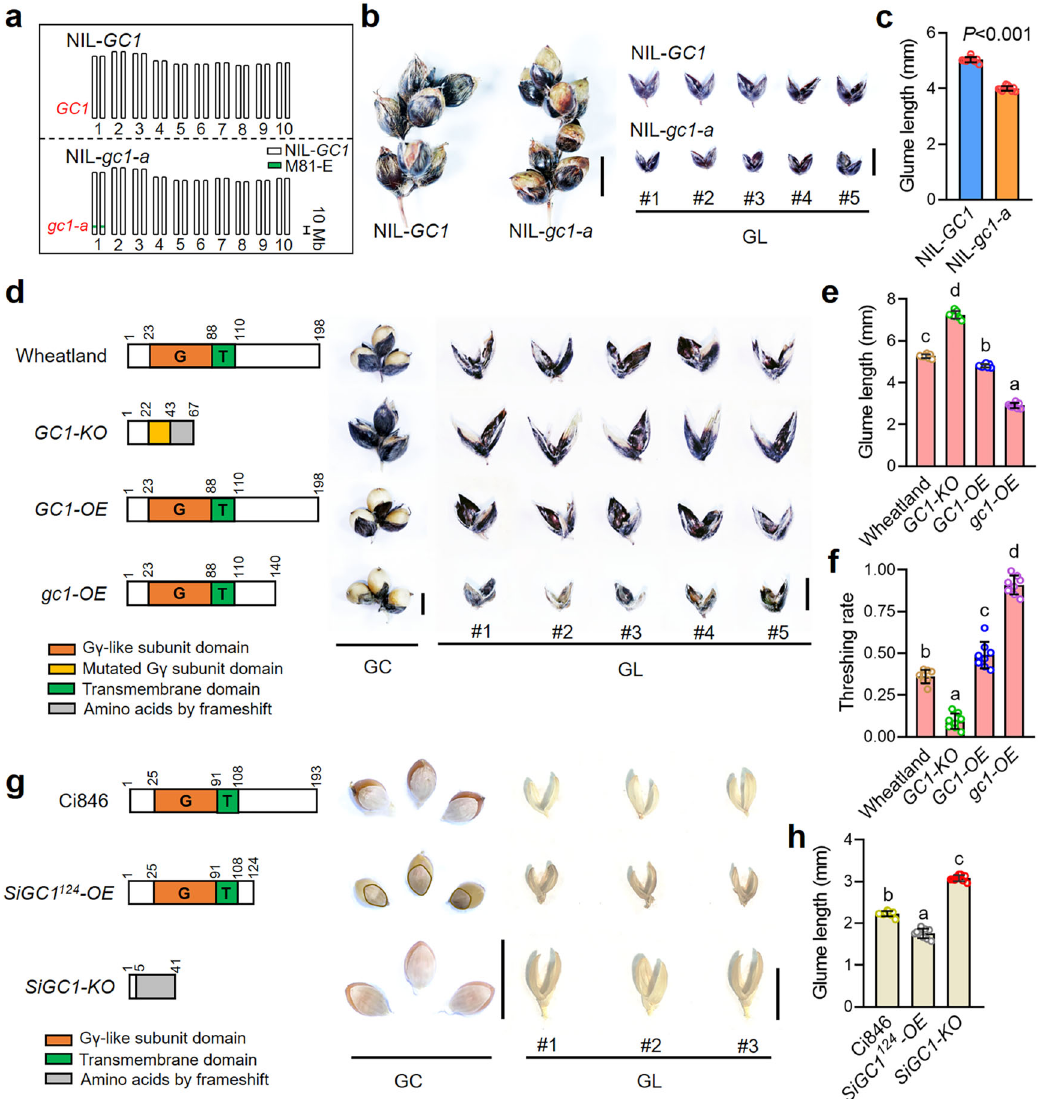
Fig. 2 The G γ -like subunit negatively controls glume coverage in sorghum and millet. a Genetic background of NIL- GC1 and NIL- gc1-a lines based on the self-crosses process derived from the cross between SN010 and M-81E. The green box in the long arm of chromosome 1 indicates the homozygous 58 Kb GC1 region derived from M-81E ( gc1-a/gc1-a ) (see “ Methods ” section). b Morphology of mature spikelet and glumes in NIL- GC1 and NIL- gc1-a . Bar = 5 mm. c Statistics of glume length in NIL- GC1 and NIL- gc1-a . Phenotypic data are mean ± s.e.m. n = 10 biological replicates. P -values were determined by two- tailed unpaired t -test. d Schematic diagram of peptide structure, mature spikelet and glumes in Wheatland (wild type of GC1 ), GC1-KO mutant, GC1-OE , and gc1-OE lines. Bar = 0.5 cm. e , f Statistics of glume length and threshing rate in the plants shown in d . Data are mean ± s.e.m. n = 8 biological replicates. g Schematic diagram of peptide structure, mature spikelet, and glumes in Ci846 (wild type of SiGC1 ), SiGC1 124 -OE line and SiGC1-KO mutants. Bar = 0.5 cm. The glume outline of SiGC1 124 -OE is highlighted by yellow lines. h Statistics of glume length in the plants shown in g . Data are mean ± s.e.m. n = 9 biological replicates. G, G protein γ subunit domain. T transmembrane domain, GC glume coverage, GL glume length. P values in e , f , h were determined by one-way ANOVA with Tukey ’ s multiple comparisons test. Source data are provided as a Source Data fi